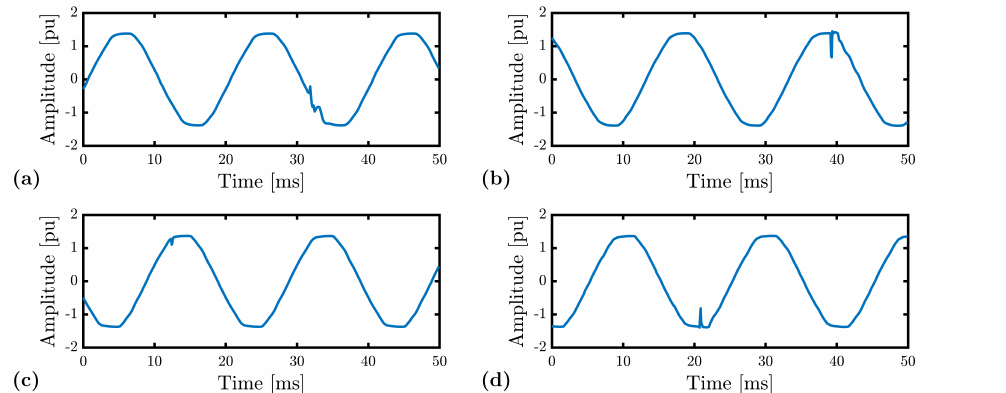
Figure 1. ( a – d ) Example of four acquired power grid voltage normalized segments. Each segment has 625 acquired samples with 16-bit DAQ at 12.5 kS/s, which corresponds to segments with 50 ms. The four examples highlight the difference in transient amplitudes, durations and relative phase